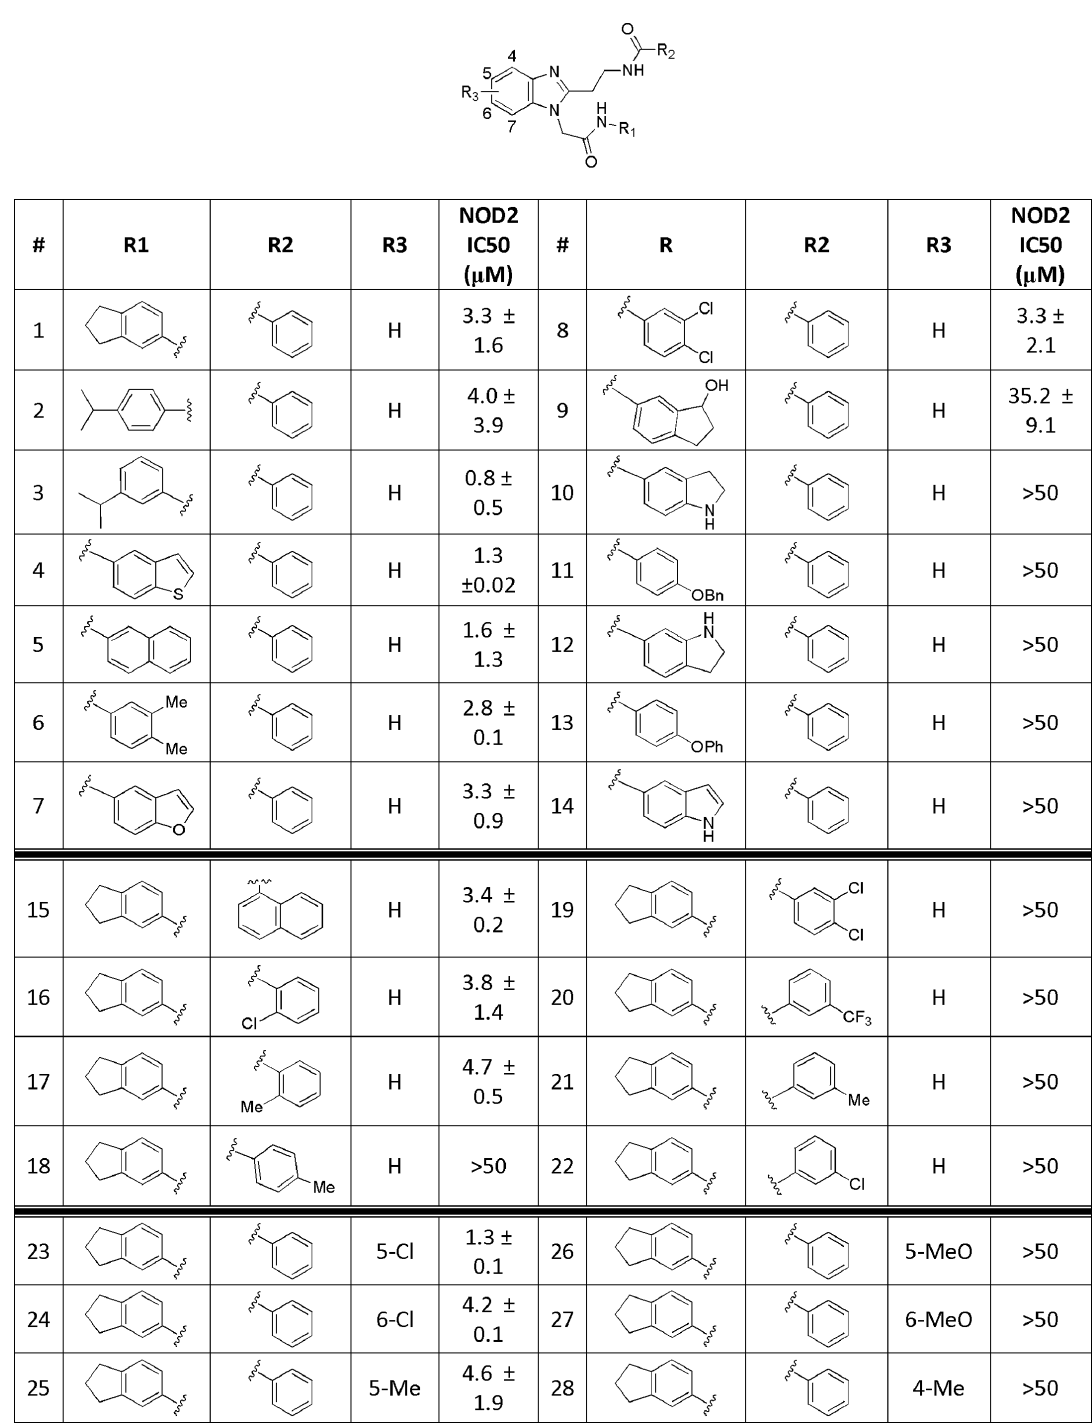
Figure 4. Structure-activity relationship for GSK669 analogs in the MDP-stimulated IL-8 production assay in 293/hNOD2 cells. doi:10.1371/journal.pone.0069619.g004 TNF a and IL-1 b in primary human monocytes stimulated with (Figure 7A). The rank order of compound activity matched that measured for MDP-induced IL-8 in HCT116 cells, irrespective of